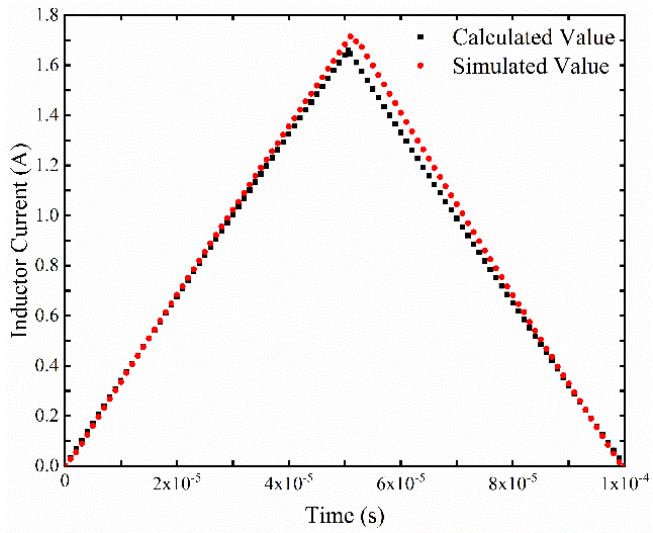
Figure 7. Calculated and simulated values of inductor current in a single cycle.